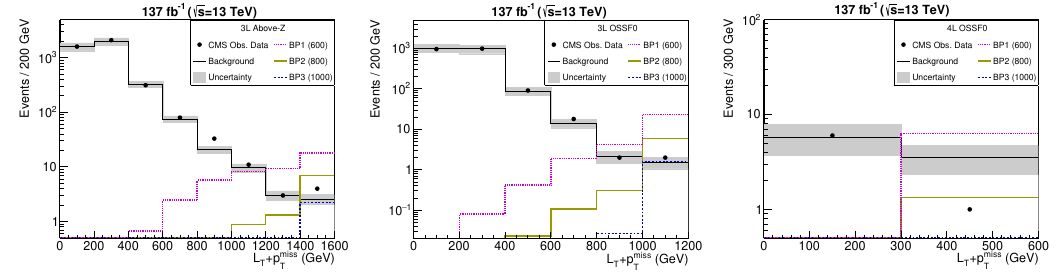
Figure 1 . L T + p miss distributions of the expected background, signal and observed events for 3L T above-Z (left), 3OSSF0 (middle) and 4OSSF0 (right) SRs. The signal predictions are shown for three benchmark masses. See text for